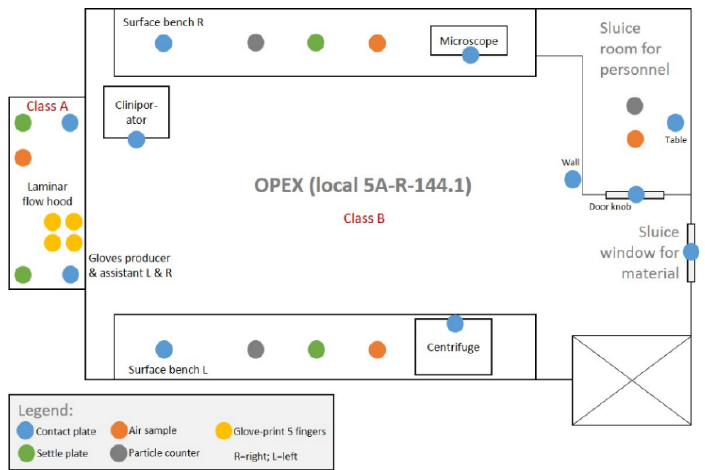
Figure 3. Environmental monitoring during production. The figure illustrates the laboratory room of the LTTC with its critical compartments and devices. The airlock for the entry of personnel (class C) is tested for particles, microbes in the air and on doorknob and table; the sluice window for the entry of material is tested with a contact plate. In the class B laboratory, all surfaces and one wall are tested for particle and microbiological matter using the air-sampler, and for living organisms using the settle and contact plates; all devices (centrifuge, microscope, Cliniporator TM ) are tested for microorganisms by contact plates. The interior of the Class A laminar flow hood and personnel gloves are tested for contaminations. A total of 26 sites are tested, i.e., 4 air samples, 3 particle counts, 11 contact plates, 4 settle plates, 4 glove